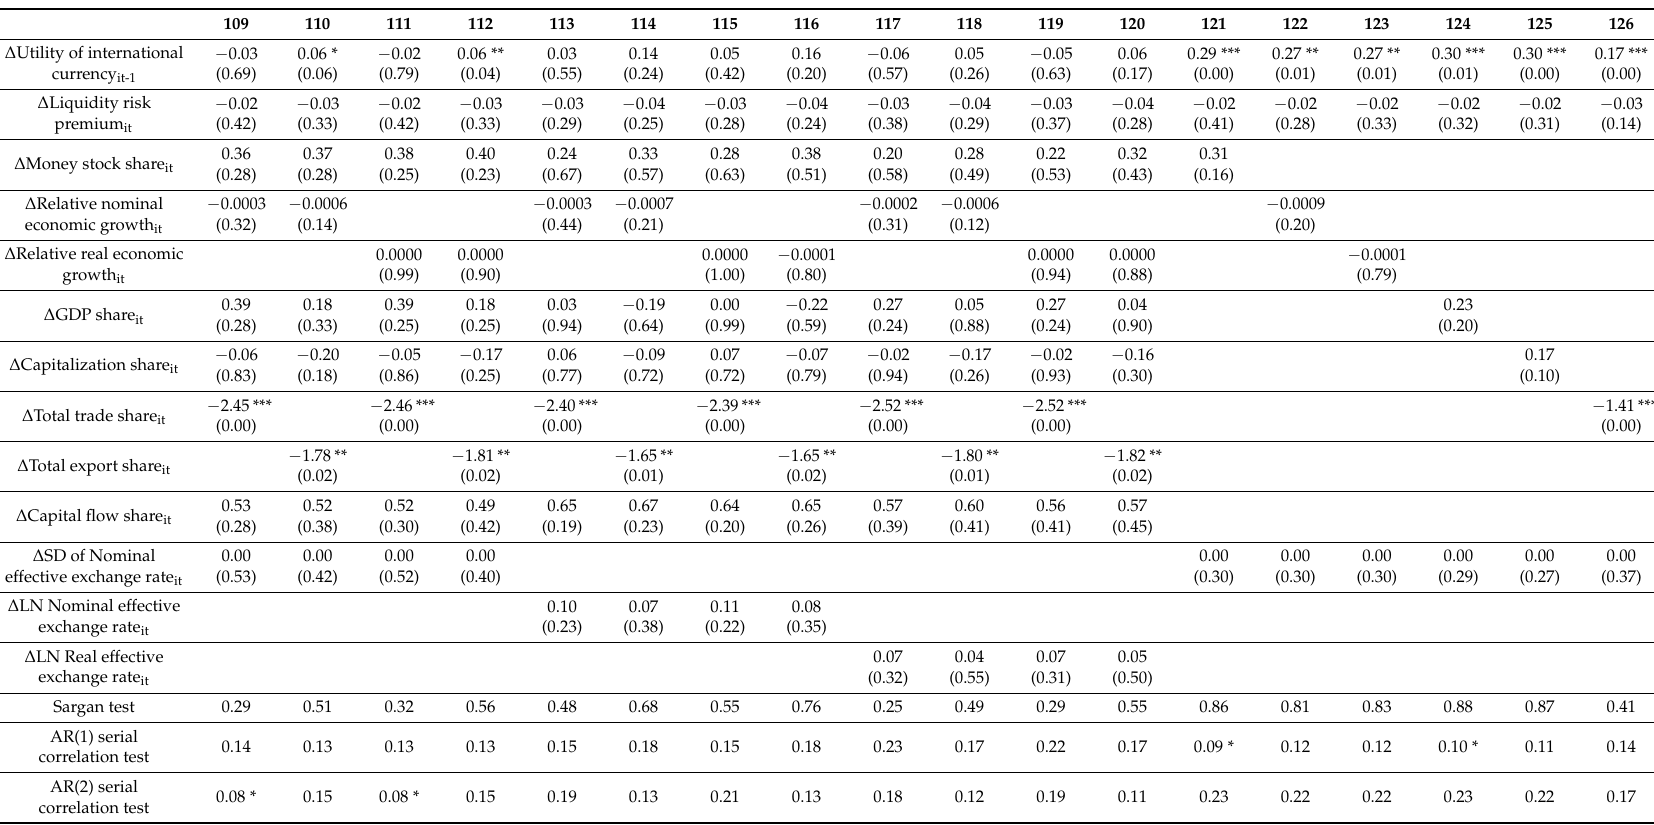
Table 5. Determinants utility of international currency (real interest rate